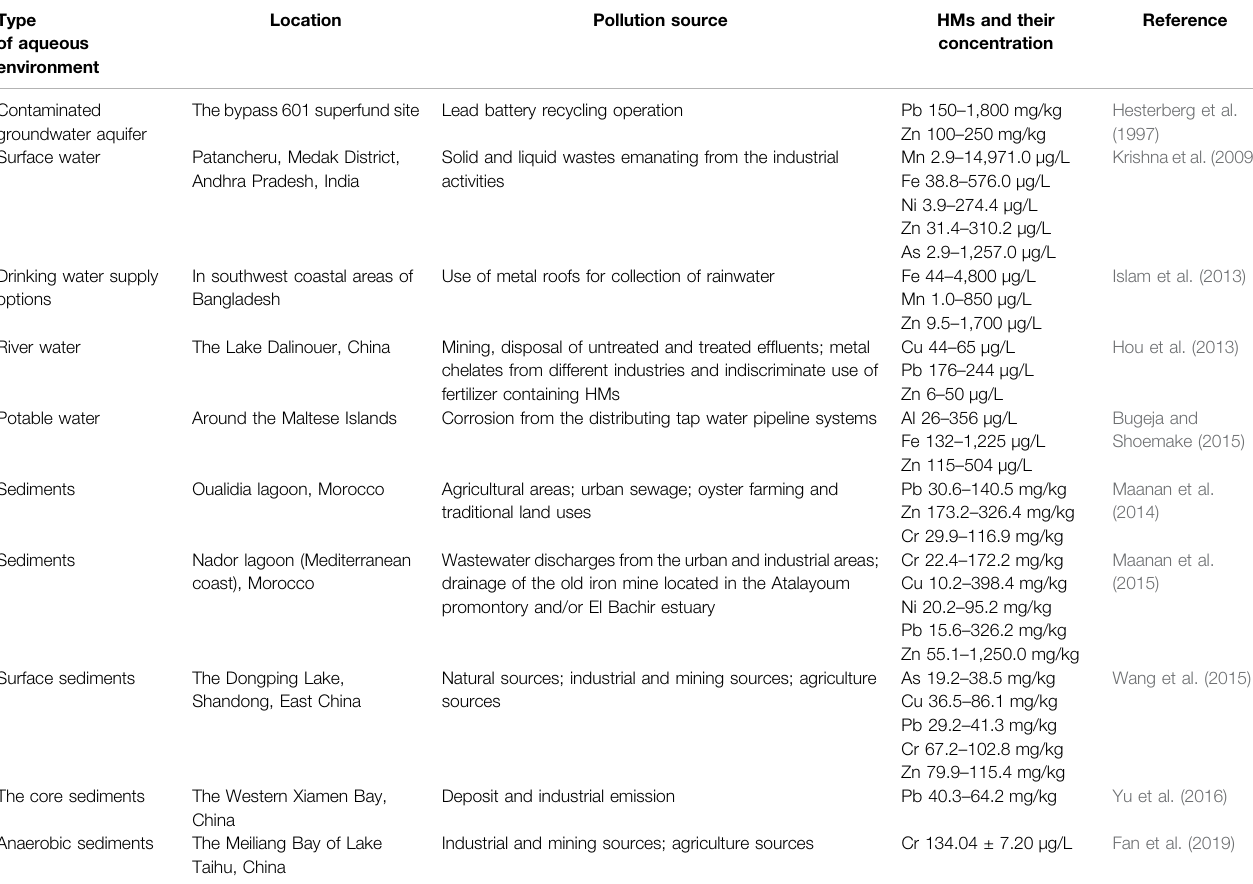
TABLE 2 | Source and concentration of HMs in the aqueous